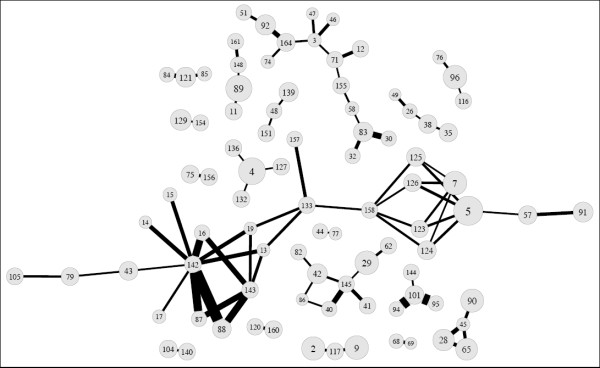
Visualization of the interaction among apoptosis-related sequence variants using Statistical Epistasis Network Modeling (SEN)-guided MDR. The Statistical Epistasis Network (SEN) was generated using a pairwise interaction strength cut-off or 1%. Overall, the model has 91 vertices (single SNPs), 80 edges (pairwise SNPs), and 18 components ("sub-networks" of vertices and edges). The largest connected component, shown in the center and spanning the entire length of this model, has 24 vertices and 34 edges. Each number in Figure 1 corresponds with a specific apoptosis-related SNP analyzed in the current study, as summarized in Additional file 2.